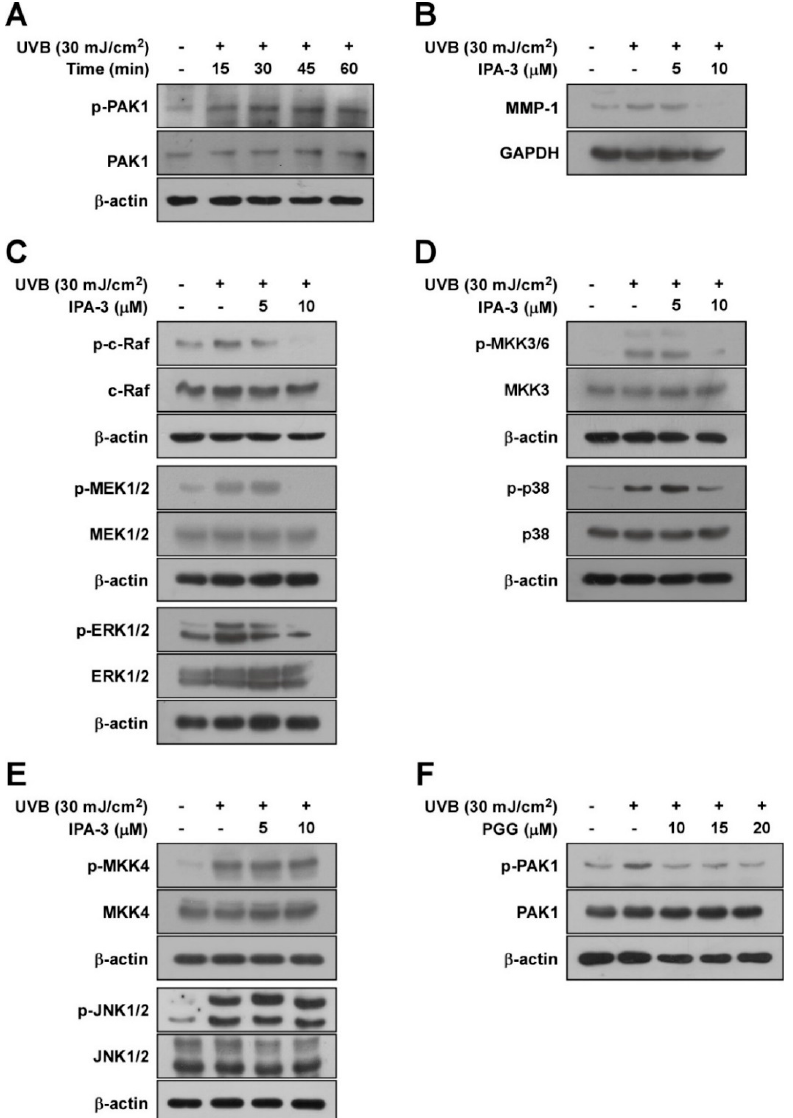
Figure 3. The role of PAK1 on UVB-induced MMP-1 expression in HaCaT cells. ( A ) A time course of UVB-induced phosphorylation of PAK1 in HaCaT cells. After serum-free starvation, cell were irradiated with UVB (30 mJ / cm 2 ) at di ff erent time points as indicated, whole cell lysates were collected. ( B ) E ff ect of IPA-3 on UVB-induced MMP-1 expression in HaCaT cells. Cells pretreated with IPA-3 (5 and 10 µ M) for 1 h were harvested 4 h after exposure to UVB (30 mJ / cm 2 ). ( C–E ) Inhibitory e ff ect of IPA-3 on UVB-induced phosphorylation of ERK, p38 and JNK signaling in HaCaT cells. Cells pretreated with IPA-3 (5 and 10 µ M) for 1 h were harvested 15 min after exposure to UVB (30 mJ / cm 2 ). Cells were treated with IPA-3 (5 and 10 µ M) for 1 h before being exposed to UVB (30 mJ / cm 2 ) and harvested 15 min later. ( F ) E ff ect of PGG on UVB-induced phosphorylation of PAK1. Cells were treated with